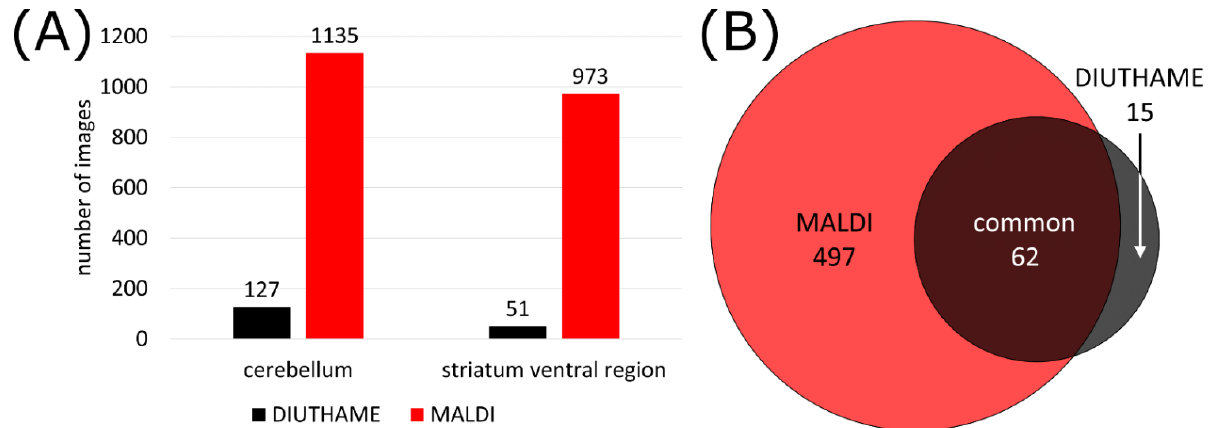
Figure 3. ( A ) Number of images available from mouse brain tissue with DIUTHAME and MALDI MSI, respectively. Only phospholipid signals in a mass range between m / z 600–1000 with a pixel coverage of >5% were considered, matrix signals were excluded. ( B ) Venn diagram of annotated phospholipids from signals detected with a MALDI or DIUTHAME MSI measurement.